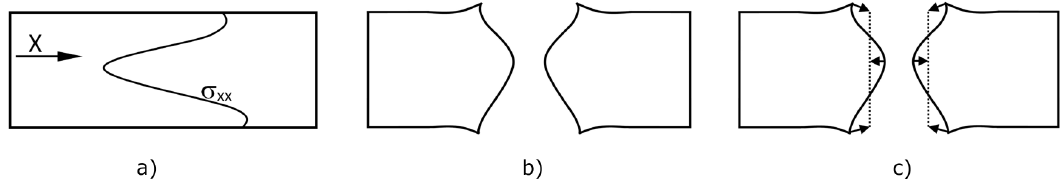
Figure 1. Schematic representation of the contour method: ( a ) original residual stress distribution; ( b ) part cut in half; ( c ) cut surface forced back to original